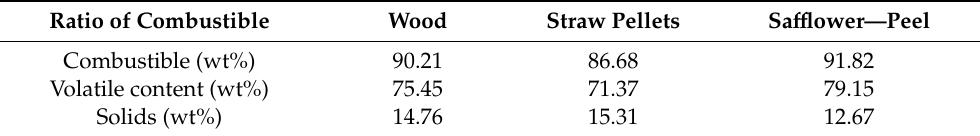
Table 4. Ratio of volatile content to solids in the combustible.